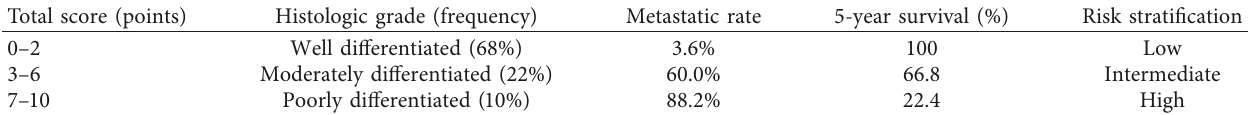
Table 2: GAPP score and risk stratification by Noriko Kimura et al. (https://doi.org/10.3390/jcm7090242). Total score